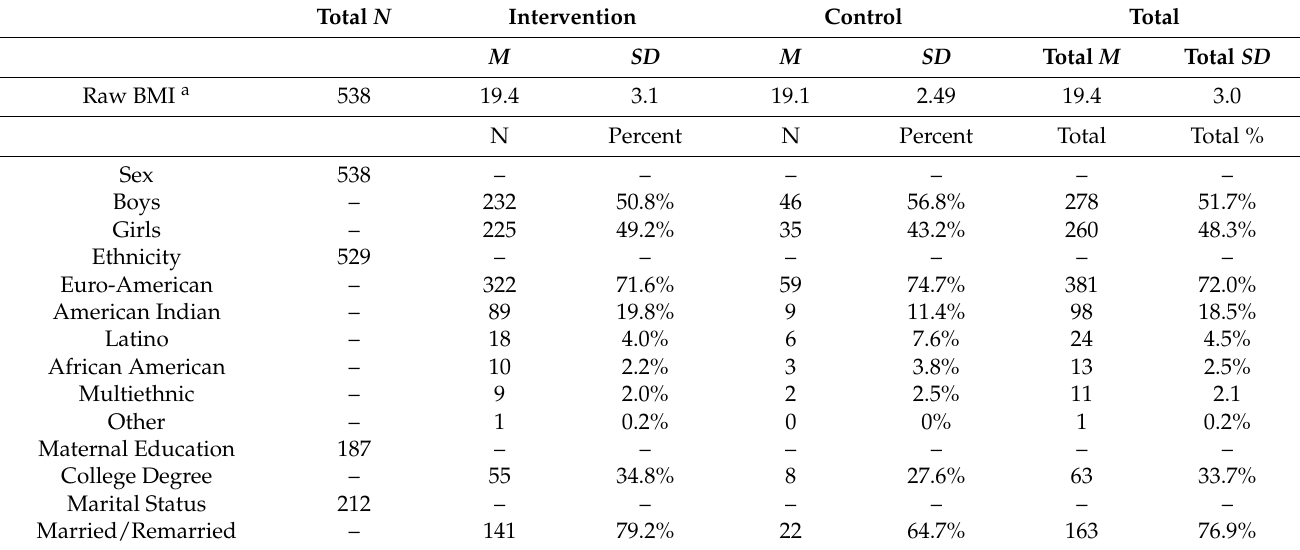
Table 1. Sample Demographics.